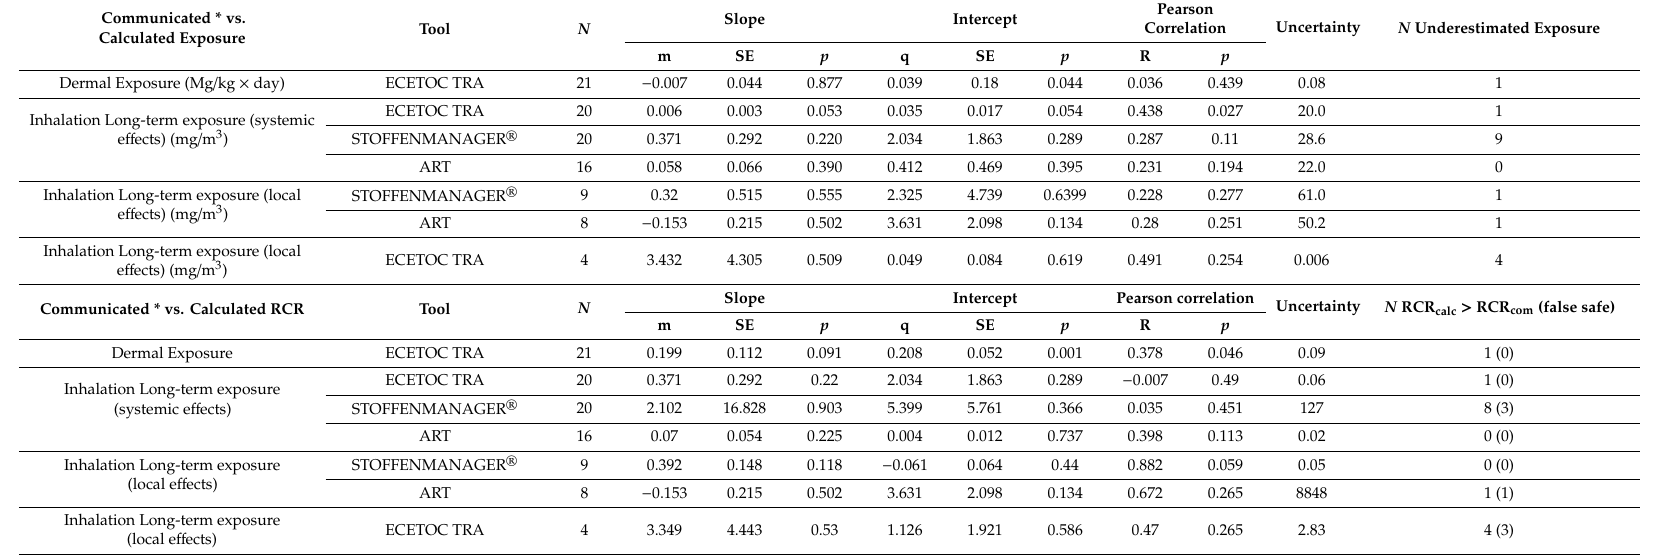
Table 12. Regression parameters between communicated and calculated exposure and RCR. The communicated exposure estimates and RCRs were used as the independent variables and the calculated exposure estimates and RCRs were used as the dependent variable in the linear regression analysis. Communicated * vs. Slope Intercept Pearson Correlation Uncertainty N Underestimated Exposure Calculated Exposure Tool N m SE p q SE p R p Dermal Exposure (Mg / kg × day) ECETOC TRA